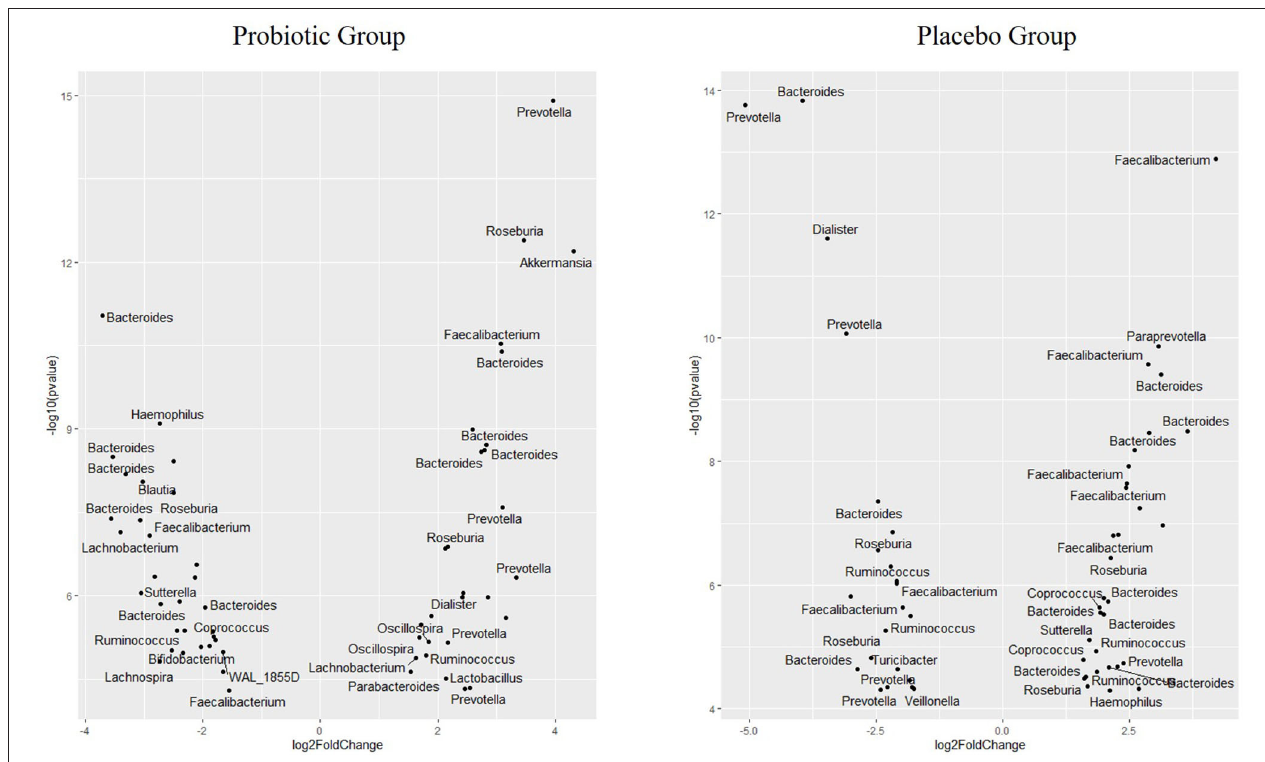
FIGURE 2 | Volcano plot showing differences in the abundance of specific microbial ASV in children receiving either a mixture of L. plantarum HEAL9 and L. paracasei 8700:2 (probiotic group) or maltodextrin (placebo group) expressed as Log2 Fold change (end of study/start of study). All ASV:s in the figure changed significantly over time with p <